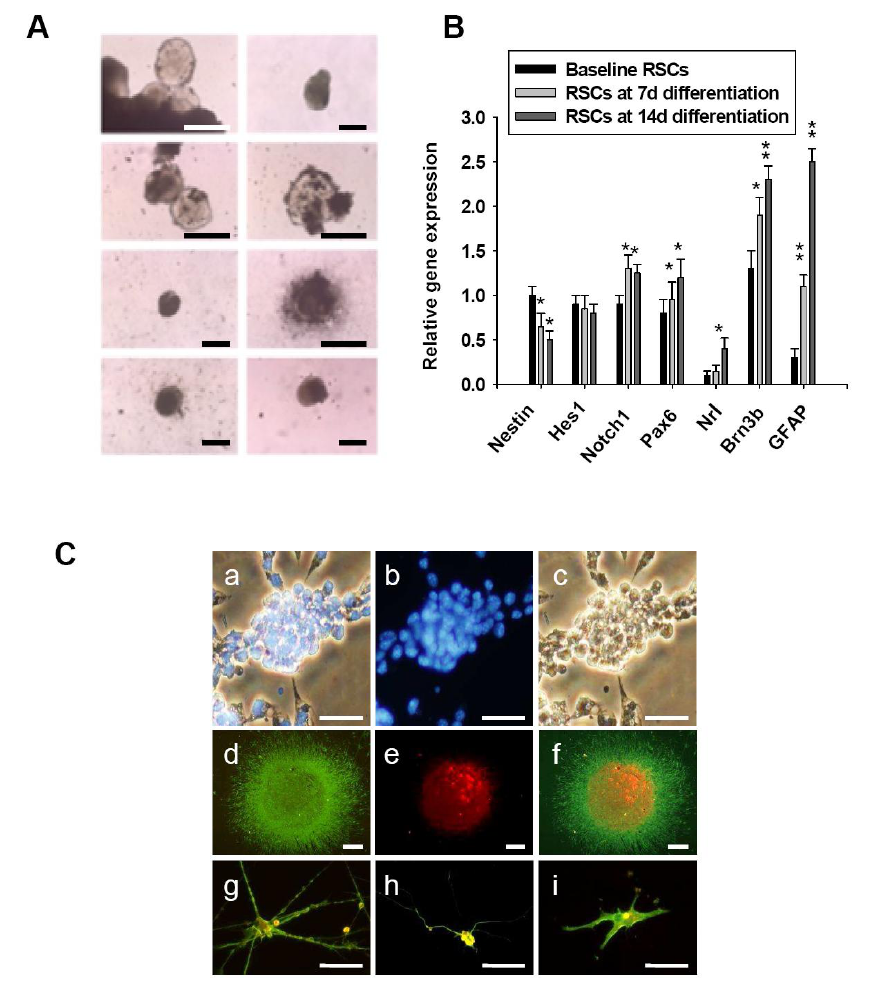
Figure 1. Isolation of rat RSCs. (A) In vitro culture of rat RSCs. The floating neurospheres were derived from RSCs and cultivated in serum-free medium with EGF and